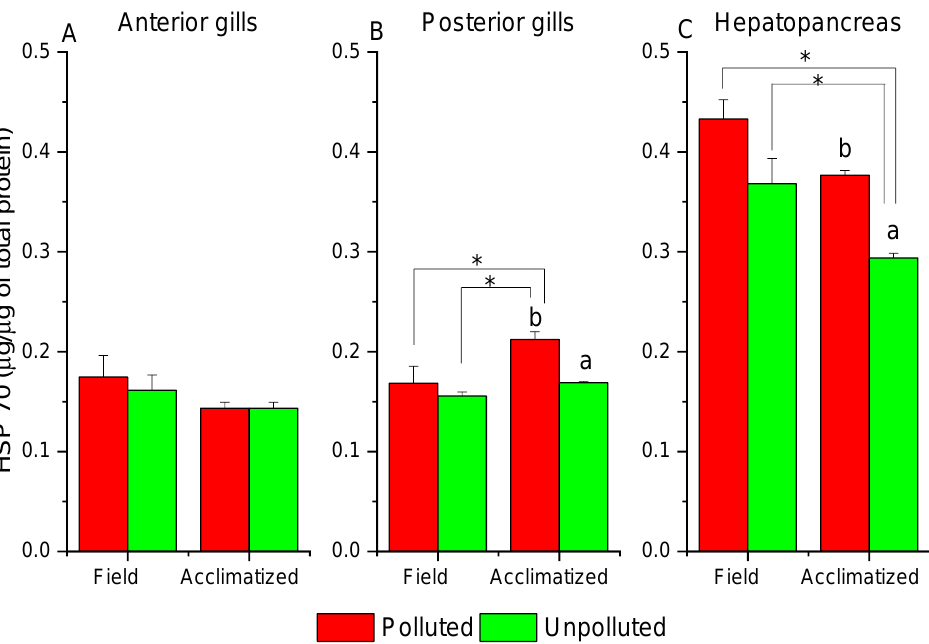
Figure 1. HSP70 levels ( µ g/ µ g of total protein) in different organs of U. cordatus from polluted and unpolluted regions analyzed in the field or after the acclimatization period. ( A ) Anterior gills. ( B ) Posterior gills. ( C ) Hepatopancreas. Different letters represent the significant differences ( p < 0.05) between the polluted and unpolluted regions, and the asterisk represents the comparison between field and acclimatized animals.